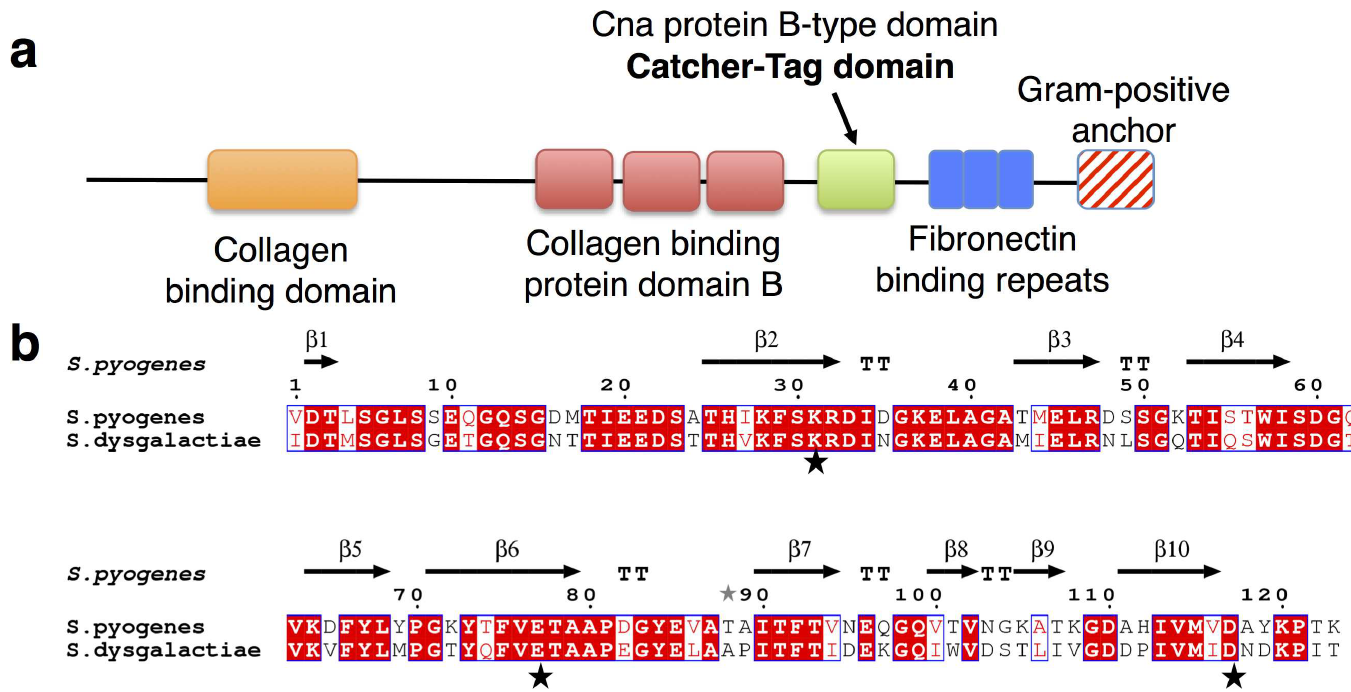
Fig 1. S . dysgalactiae CnaB domain analysis. (a) Graphicalview of domains in S . dysgalactiae fibronectin-binding protein, accession code: CAA80122.1. This was not drawn to scale. (b) Sequence alignment of S . pyogenes and S . dysgalaticae CnaB domains using Clustal Omega [21] and ESPript 3.0 [22]. Structural beta-sheetelements ( β 1- β 10) of the S . pyogenes protein are also indicatedbased on resolved S . pyogenes domain(PDB ID: 2X5P [23]). Residuesinvolvedin isopeptide formation are indicatedwith stars. The S . dysgalactiae CnaB domainused for alignmentis located at amino acids 828–950 of the S . dysgalactiae fibronectin-bindingprotein (1117 amino acids